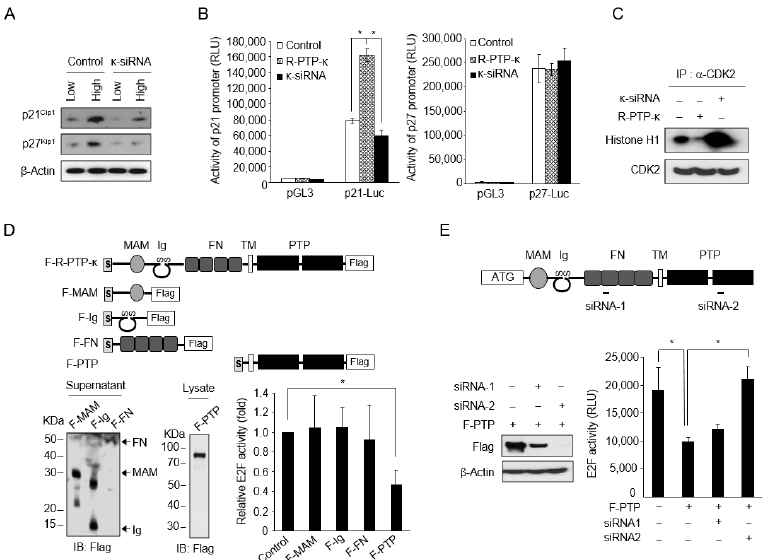
Figure 4. Regulation of E2F pathway by R-PTP- κ . ( A ) Analysis of p21 and p27 protein expression in relation to cell density and R-PTP- κ expression. HeLa cells transfected with control or κ -siRNA were plated at low and high density, cultured for 48 h, harvested, and analyzed for p21 and p27 protein expression by western blotting. ( B ) Effect of R-PTP- κ on the transcriptional activity of p21 and p27 in sub-confluent HeLa cells. The effect was examined by measuring firefly luciferase activity of the p21 or p27 promoter in cells overexpressing R-PTP- κ or expressing siRNA targeting R-PTP- κ . * p < 0.05. ( C ) Effect of R-PTP- κ on cellular CDK2 kinase activity. Total cell lysates (200 µ g) were immunoprecipitated with an anti-CDK2 antibody and assayed for kinase activity using recombinant histone H1 as a substrate. The bottom panel shows the amount of CDK2 protein in each immunoprecipitate. ( D ) Effect of R-PTP- κ domains on E2F activity in HeLa cells. Schematic depiction of the structure of the various constructs cloned into a FLAG-tagged eukaryotic expression vector (upper panel). Expression of various constructs was confirmed by western blotting and E2F activity was estimated by measuring firefly luciferase activity (lower panel). * p < 0.05. ( E ) Regulation of E2F-dependent luciferase activity in HeLa cells by siRNA-1 and -2 targeting R-PTP- κ . HeLa cells were co-transfected with luciferase promoter-reporter plasmid, and siRNA-1 or -2 and/or the isolated PTP domain. * p <